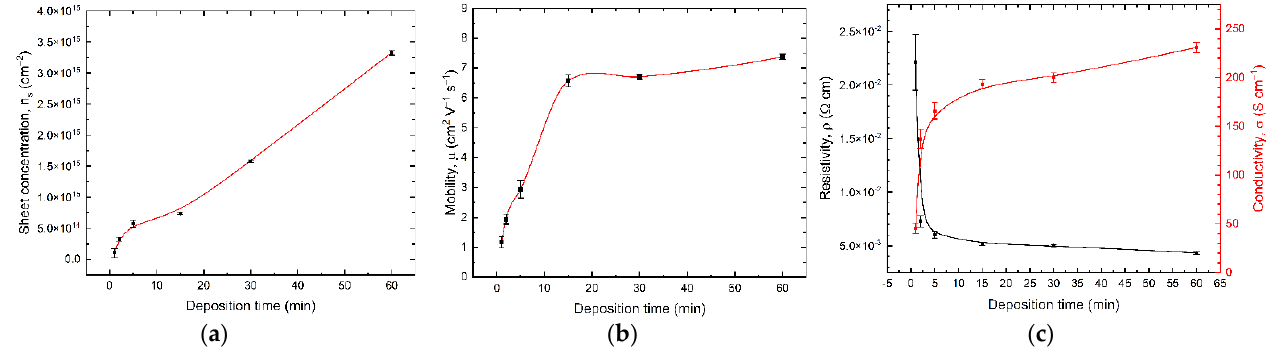
Figure 10. ( a ) Sheet concentration, ( b ) mobility, ( c ) resistivity, and conductivity of the NCG thin films as a function of deposition time .